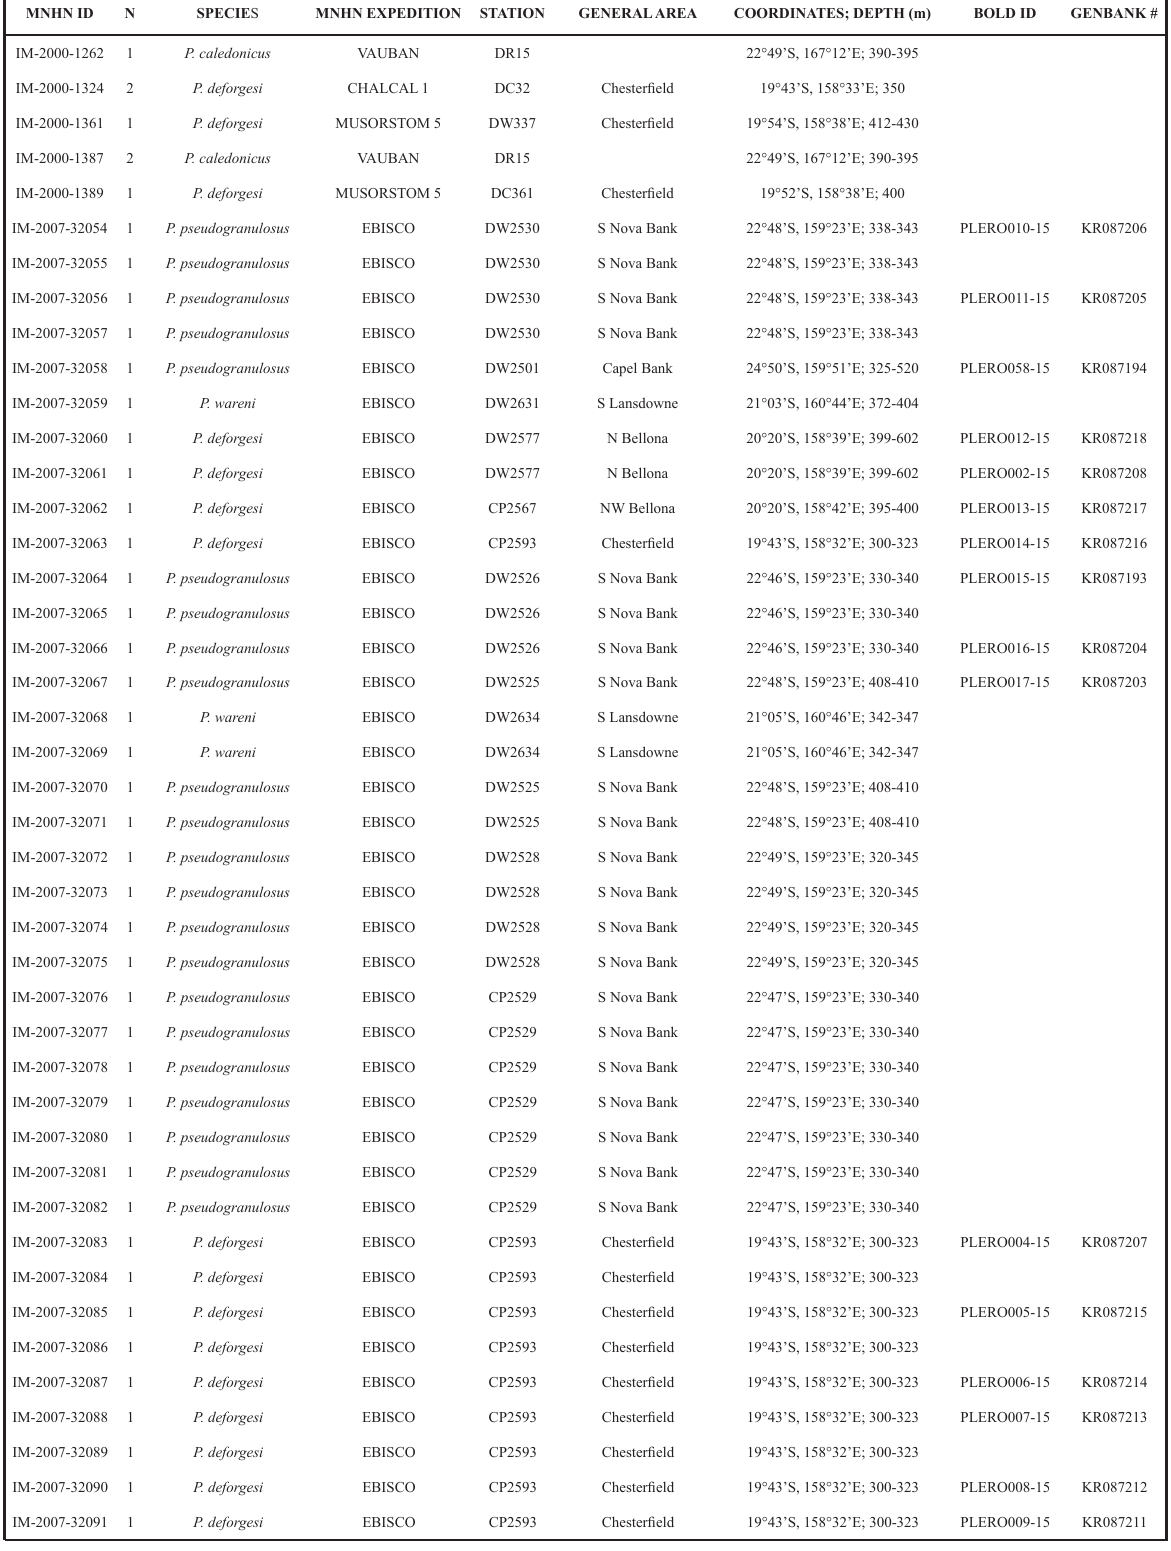
Table 1. list of